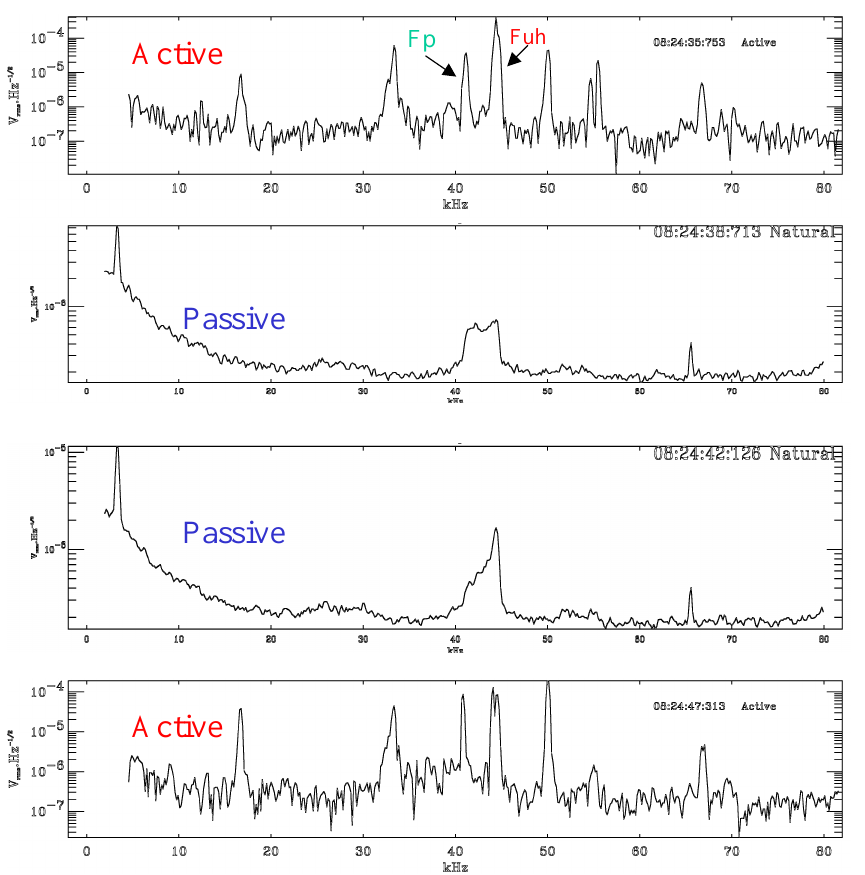
Fig. 2. Consecutive active and pas- sive amplitude versus frequency spec- tra. Time separation between spectra is 2–3s. The enhanced natural plasma emission has its low and high cutoff at Fp and Fuh , respectively. The emis- sion at Fuh is seen as unstable on the second passive